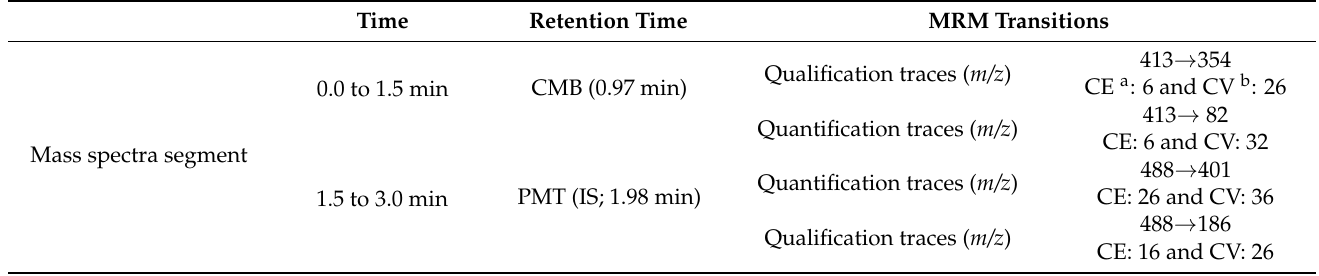
Table 2. MRM-tuned mass spectrometric parameters for the estimation of CMB and PMT